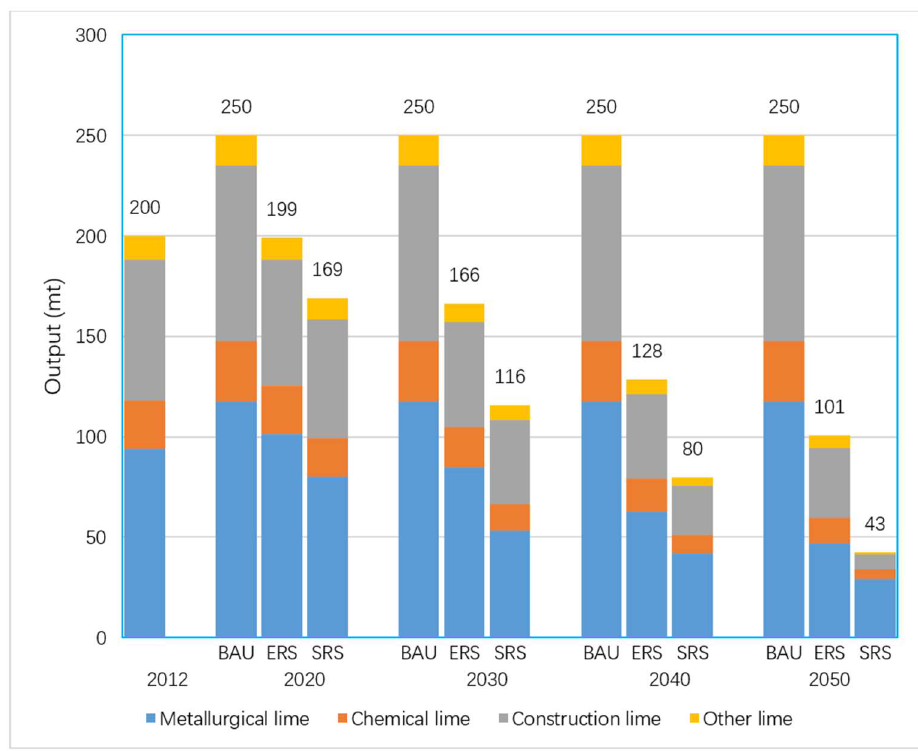
Figure 3. Lime productions in each scenario.